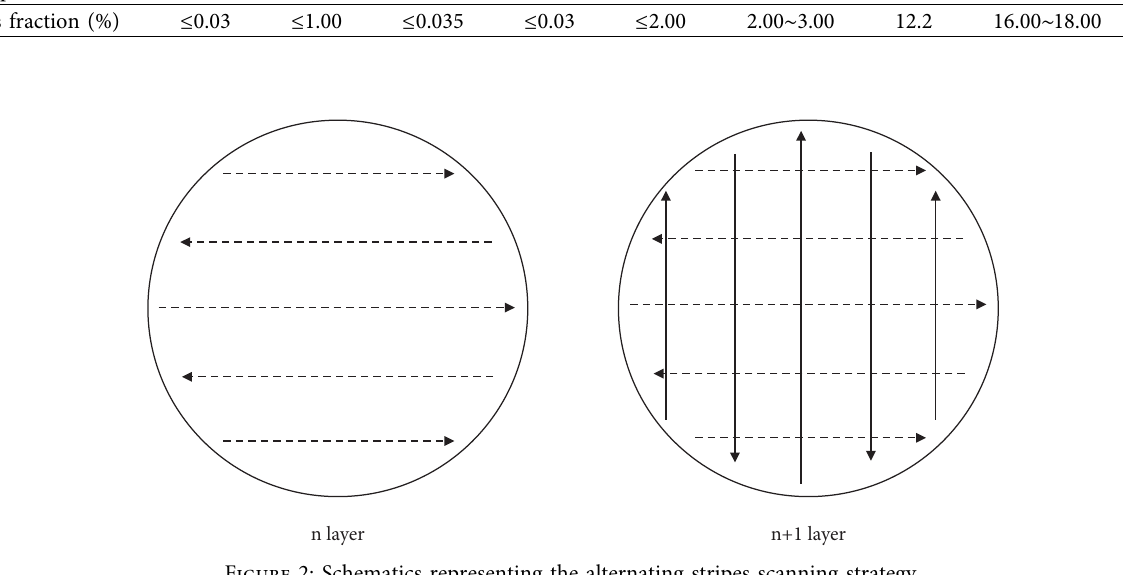
Figure 2: Schematics representing the alternating stripes scanning strategy.